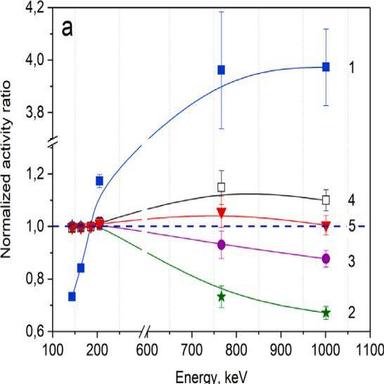
Line activity consistency evaluation.